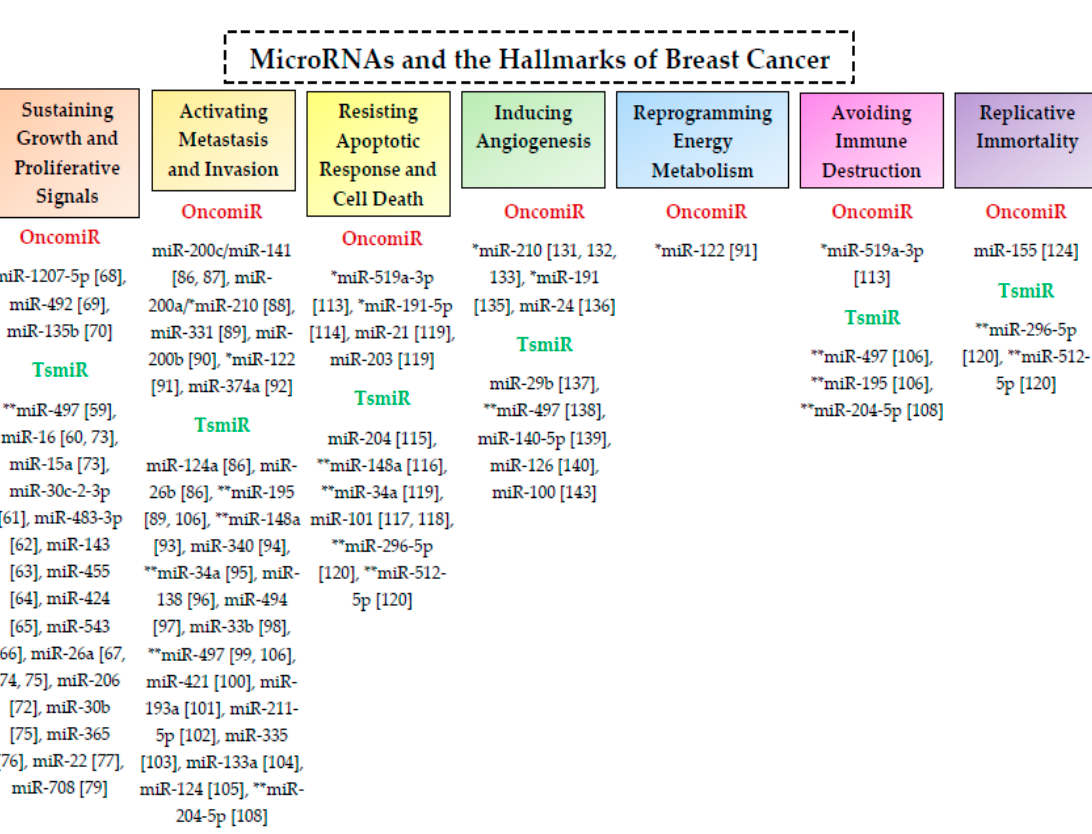
Figure 3. MicroRNAs involved in post-transcriptional regulatory interactions in breast cancer. The oncomiRs and tsmiRs associated with various hallmark characteristics of breast cancer are listed under the red and green subheadings, respectively. Each of these miRNAs can post-transcriptionally regulate a large number of genes involved in breast cancer. The symbols * and ** indicate the oncomiRs and tsmiRs, respectively, that regulate more than one of the hallmark features of breast cancer.